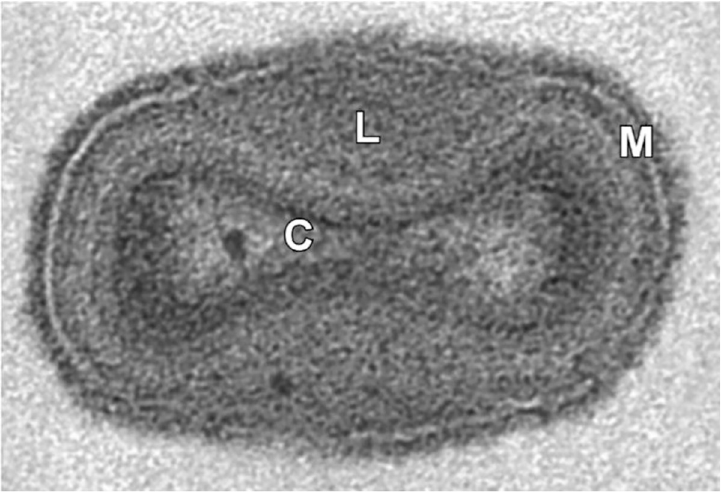
Fig 1. An electron micrograph of vaccinia virus. The three subviral structures, core (C), lateral bodies (L), and membrane (M), are labelled. Reproduced with permission of Jason Mercer.